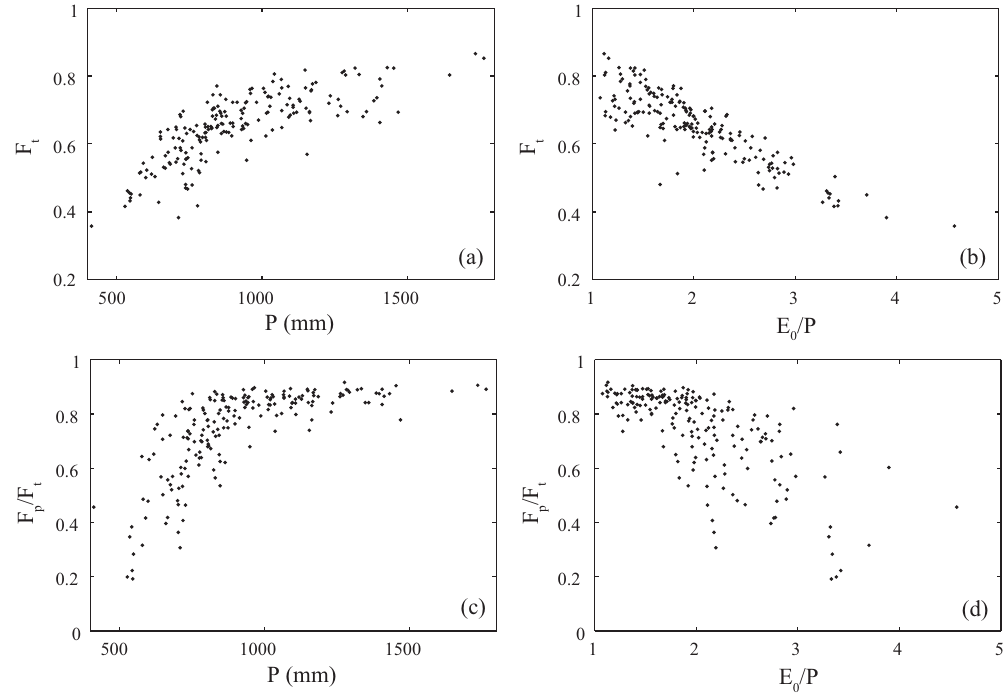
Fig. 5. Scatter plots of comparing long-term average vegetation cover (represented by mean annual value of fPAR) against mean annual precipitation ( P ) and dryness index ( E 0 /P ): (a) and (b) total vegetation cover (represented by F t ), (c) and (d) fraction of woody vegetation cover (represented by F p /F t